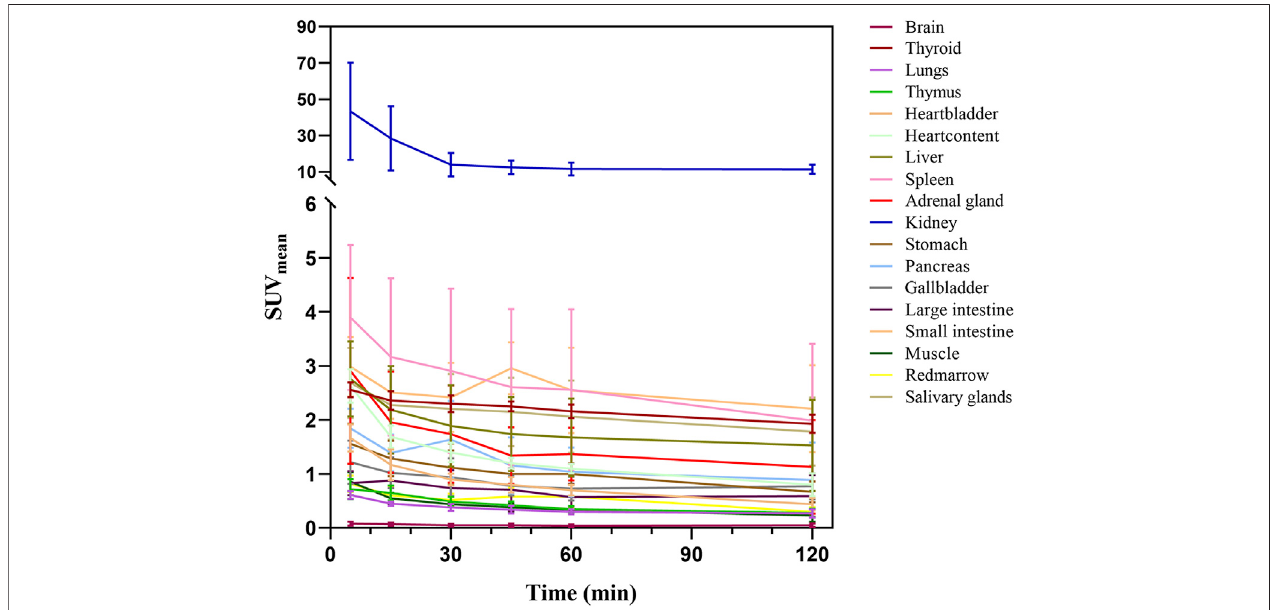
FIGURE 3 | Biodistribution of 68 Ga-DOTA-DiPSMA in healthy volunteers.